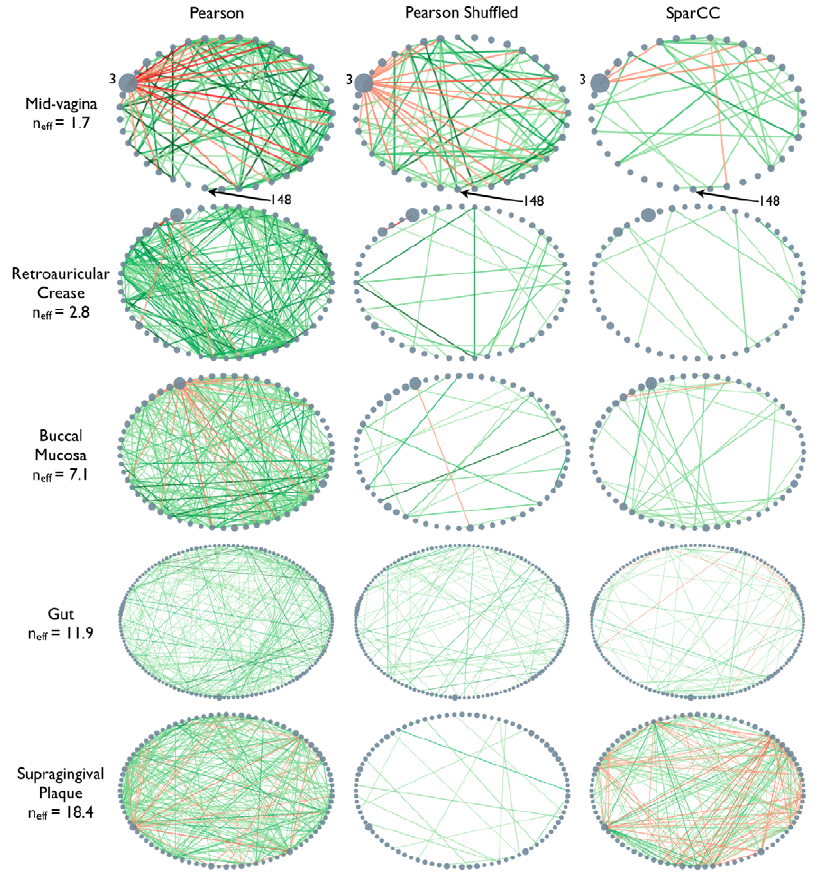
Figure 1. Similar correlation networks are observed for real world vs. randomly shuffled bacterial abundance data. Correlation networks based on 16S rRNA gene survey data collected as part of the Human Microbiome Project (HMP), inferred using Pearson correlations (left column), and SparCC (right column). Additionally, Pearson correlation networks were inferred from shuffled HMP data (middle column), where all OTUs are independent. The Pearson networks inferred from shuffled data show patterns similar to the ones seen in the Pearson networks of the real data, especially for low diversity body sites. This indicates that the observed Pearson network structure may be due to biases inherent in compositional data rather than a real biological signal. In contrast, no significant correlation were inferred from the shuffled data using SparCC (data not shown). Nodes represent OTUs, with size reflecting the OTU’s average fraction in the community. Edges between nodes represent correlations between the nodes they connect, with edge width and shade indicating the correlation magnitude, and green and red colors indicating positive and negative correlations, respectively. For clarity, only edges corresponding to correlations whose magnitude is greater than 0.3 are drawn. See Fig. S1 for all 18 HMP body